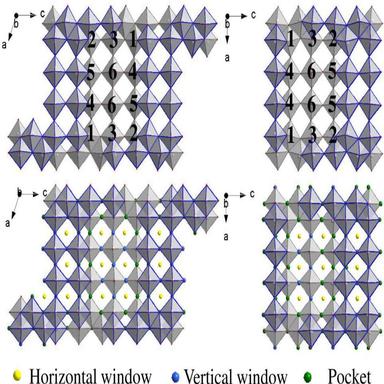
Coordination environment of Nb5+ in FeNb11O29 (above) and Li+ ions in Li23FeNb11O29 (down), in the monoclinic (left) and orthorhombic structures (right). Different kind of Li sites are highlighted with different colours.